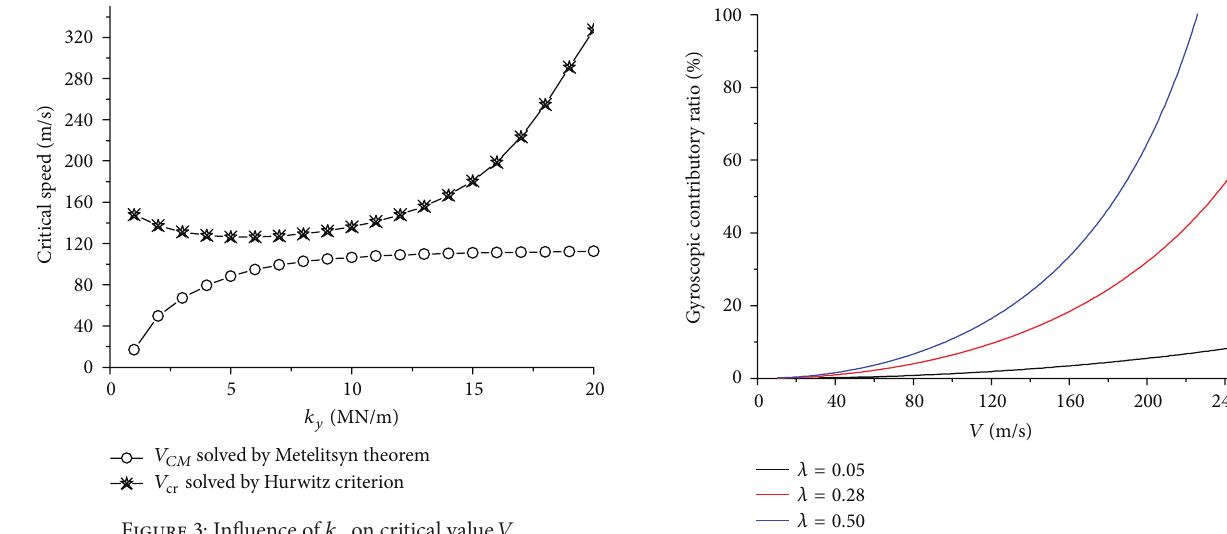
Figure 3: Influence of 𝑘 𝑦 on critical value 𝑉 .